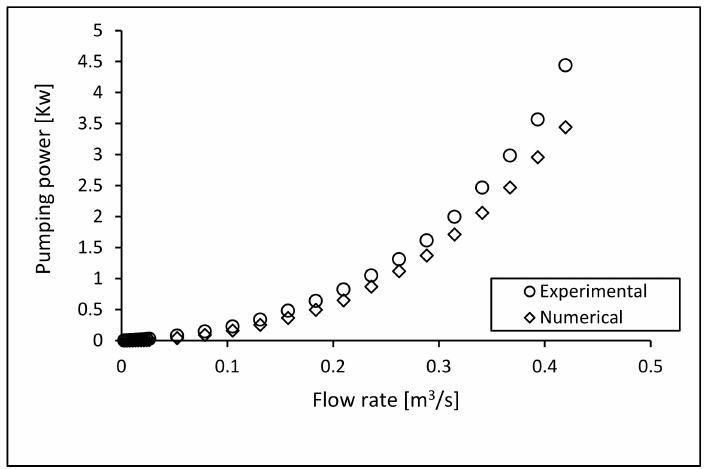
Figure 14. Numerical and experimental pumping power at different inlet flow